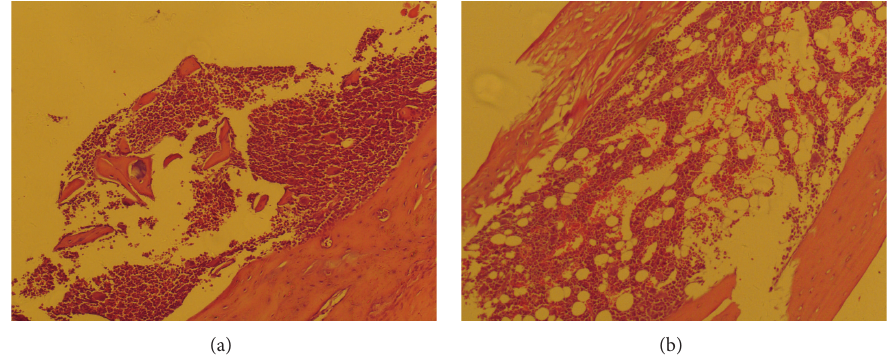
Figure 1: Pathology of bone marrow in mice with untreated (a) or BMF (b). On d14 after BMF induction, mice were sacrificed. Bone marrow were collected, fixed, embodied, sectioned, stained with H&E, and examined by using an Olympus microscope.